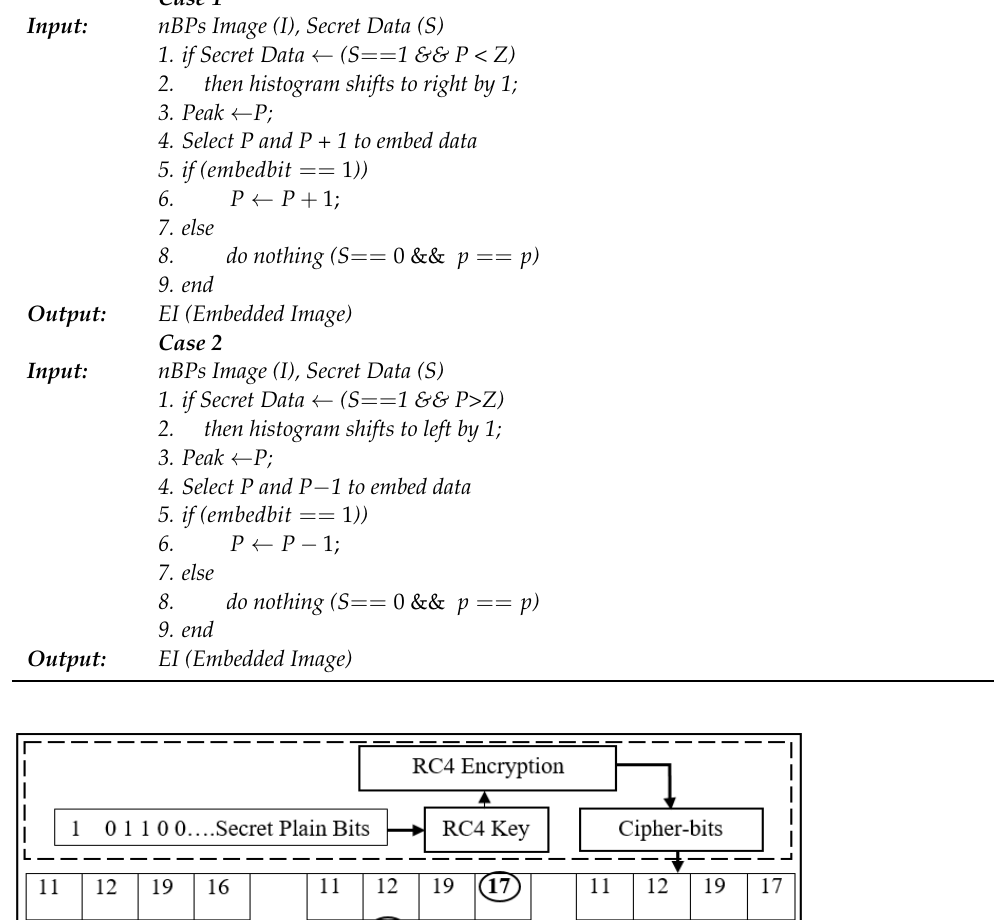
Algorithm 1: Pseudocode Embedding Algorithm of the Proposed Scheme.